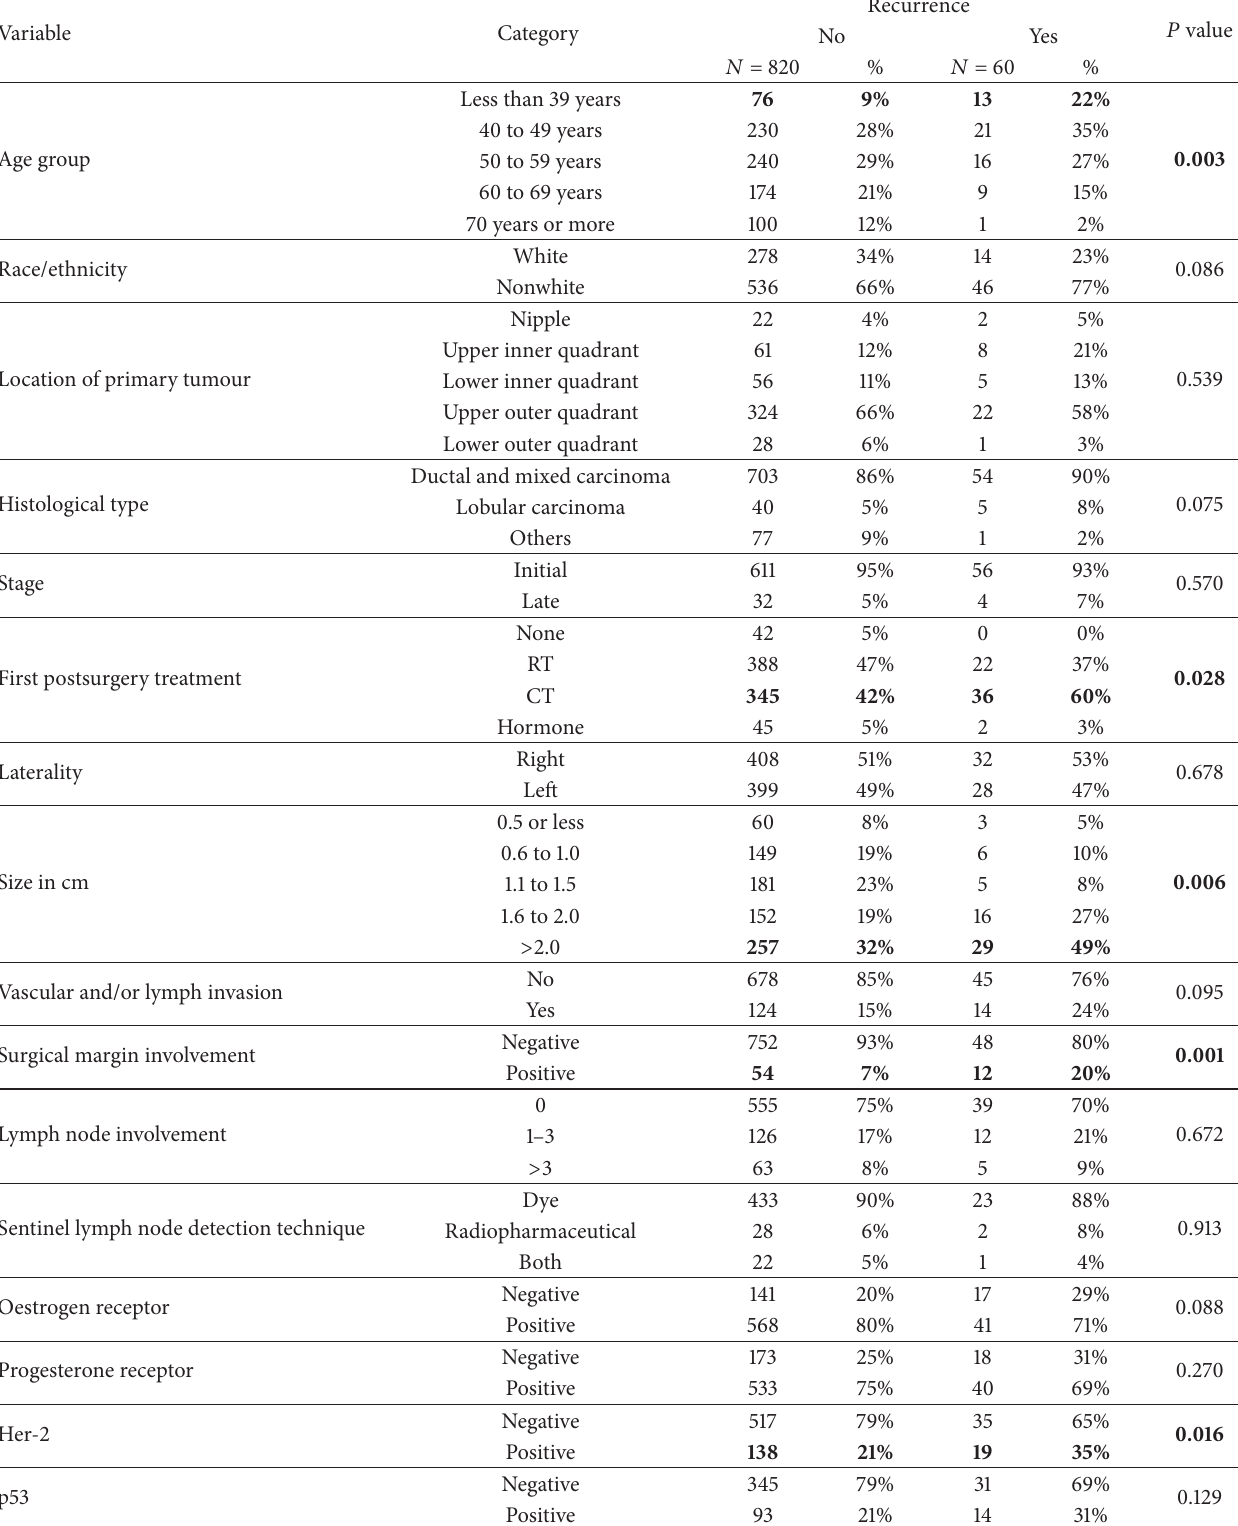
Table 2: Relationships between sociodemographic and clinical variables and the incidence of breast cancer recurrence in women who underwent breast-conserving surgery and were registered in HSRC during the period from January 1, 2000 to December 31,